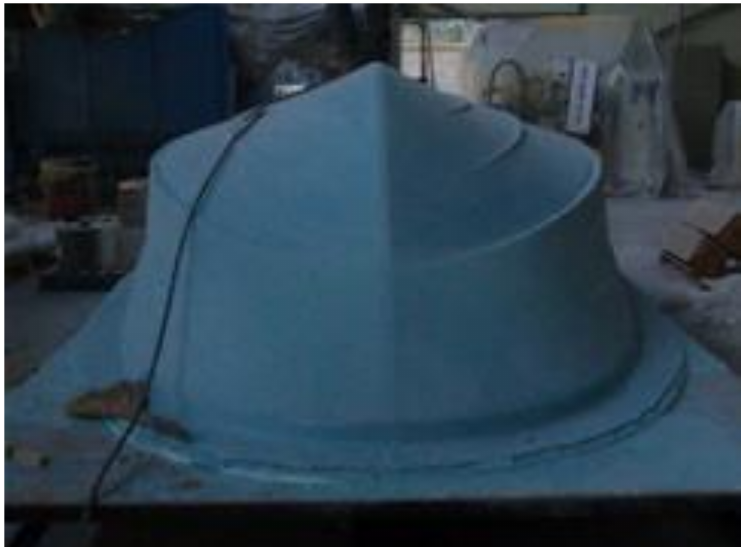
Figure 13. Manufacturing of mock up by five-axis